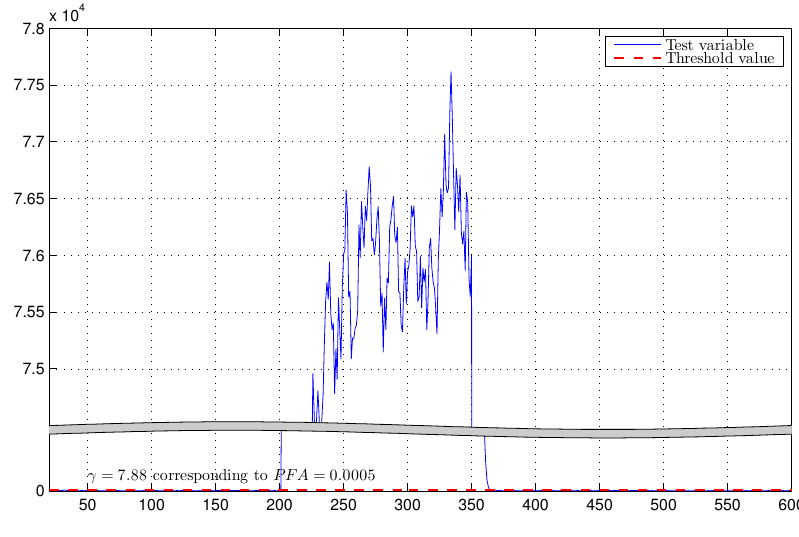
Figure 3. Test variable for the electric motor system.